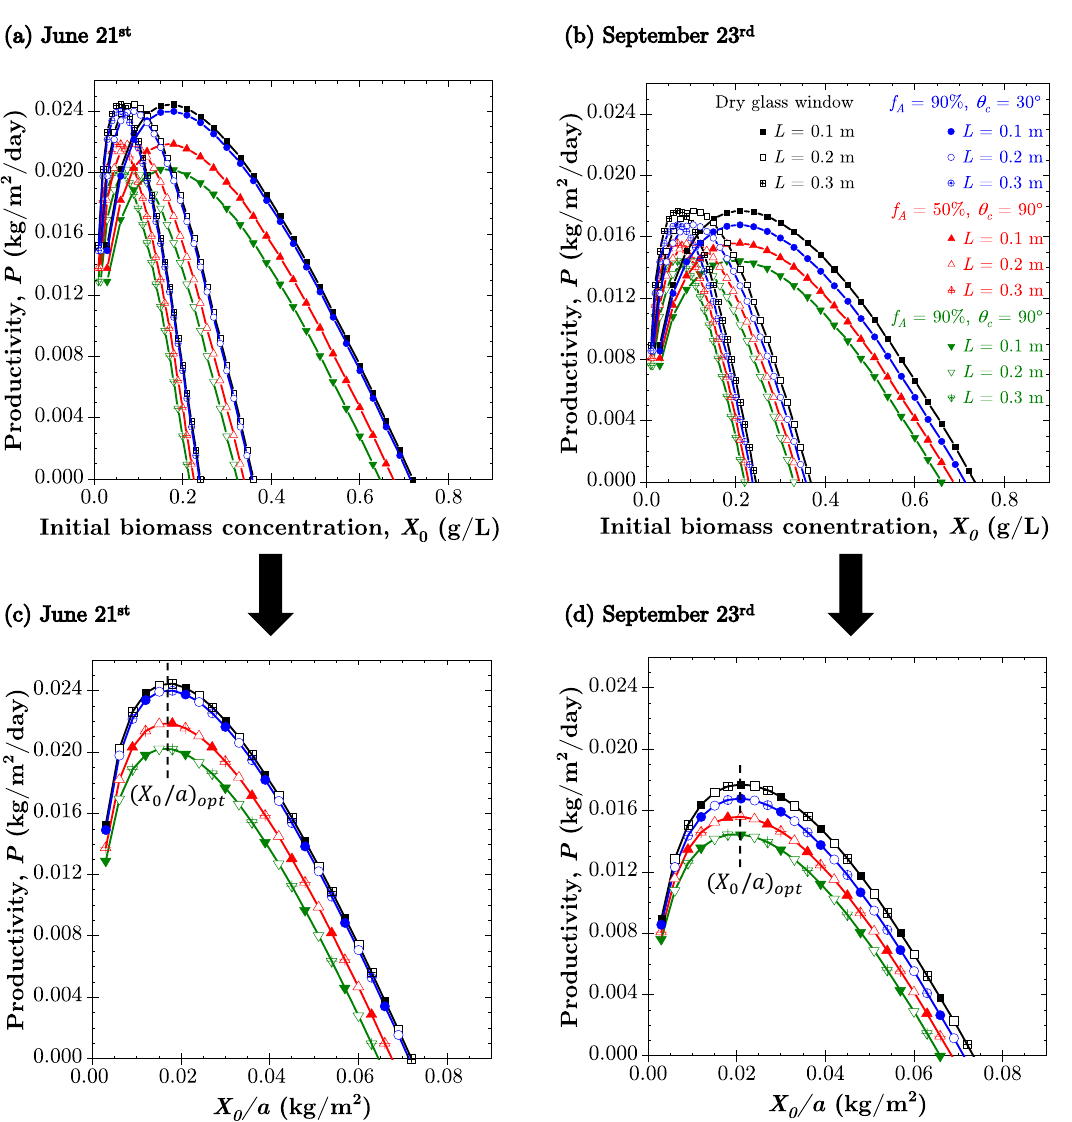
Figure 8. Daily areal PBR biomass productivity P as a function of ( a , b ) starting biomass concentration X 0 for various PBR depths L and window conditions and ( c , d ) the same daily areal PBR biomass productivity P as a function of the microalgae culture initial optical thickness represented by X 0 / a , on ( a , c ) 21 June and ( b , d ) 23